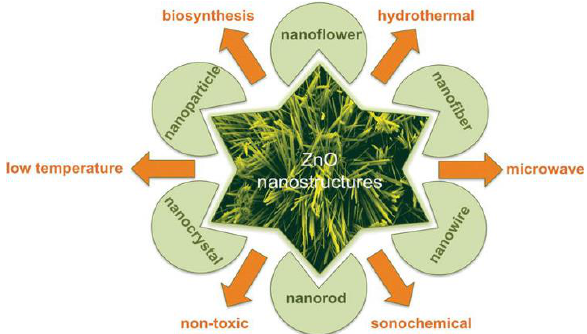
Figure 8. Synthetic strategies for ZnO nanostructures with various morphologies. Reproduced from